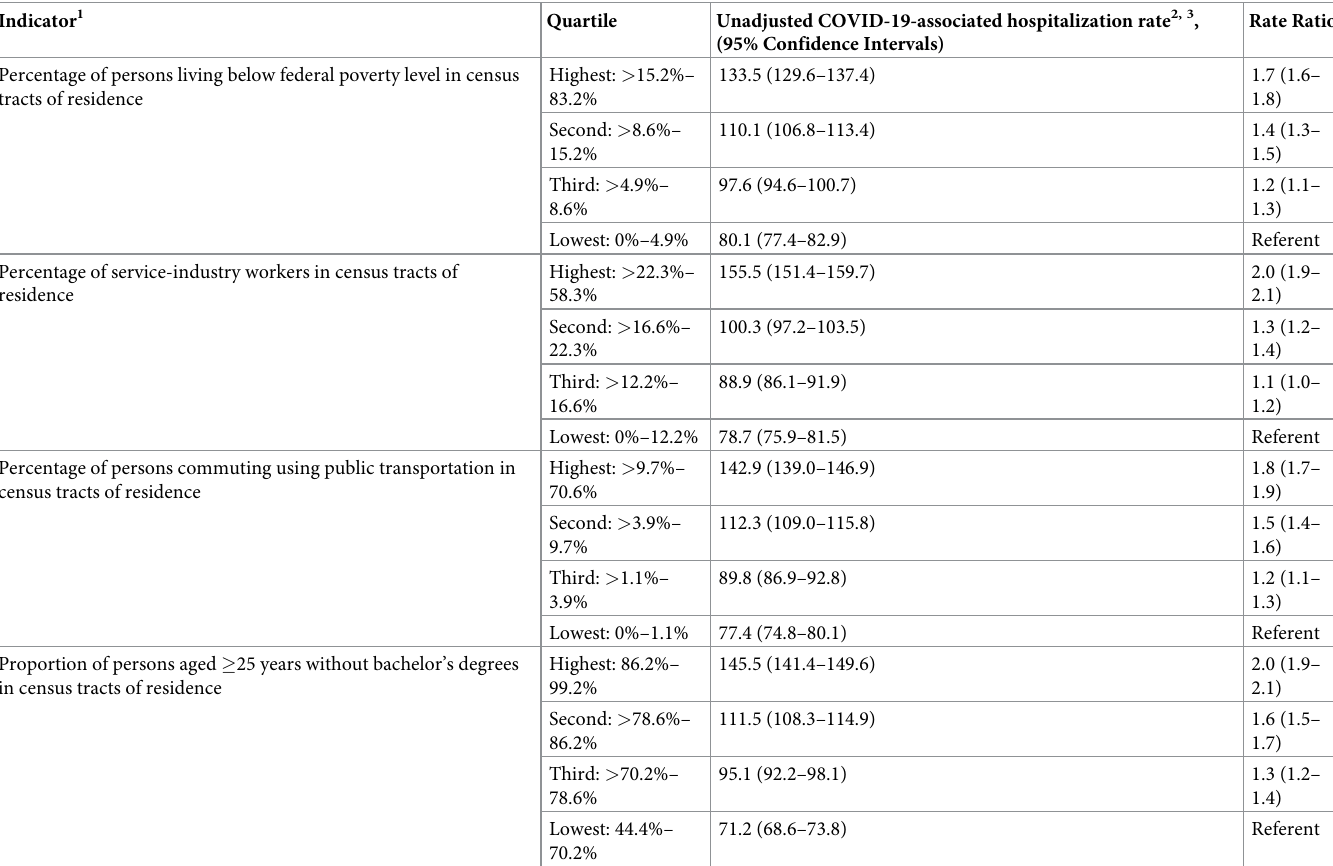
Table 2. Unadjusted COVID-19-associated hospitalization rates, by socioeconomic strata within census tracts—COVID-NET catchment areas in 14 states, March– April 2020. Indicator